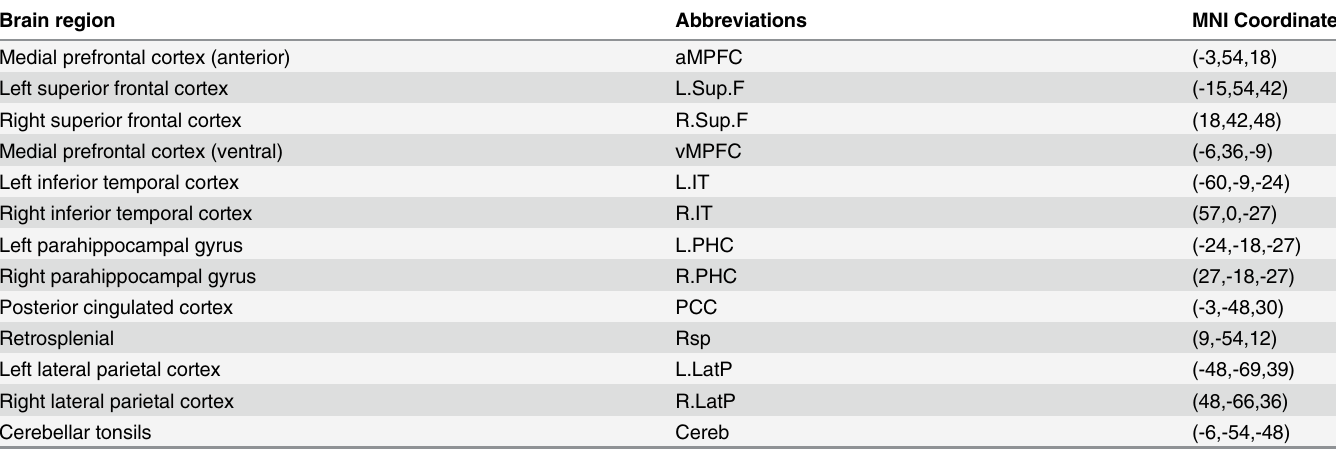
Table 1. Thirteen Regions of Interest in DMN.